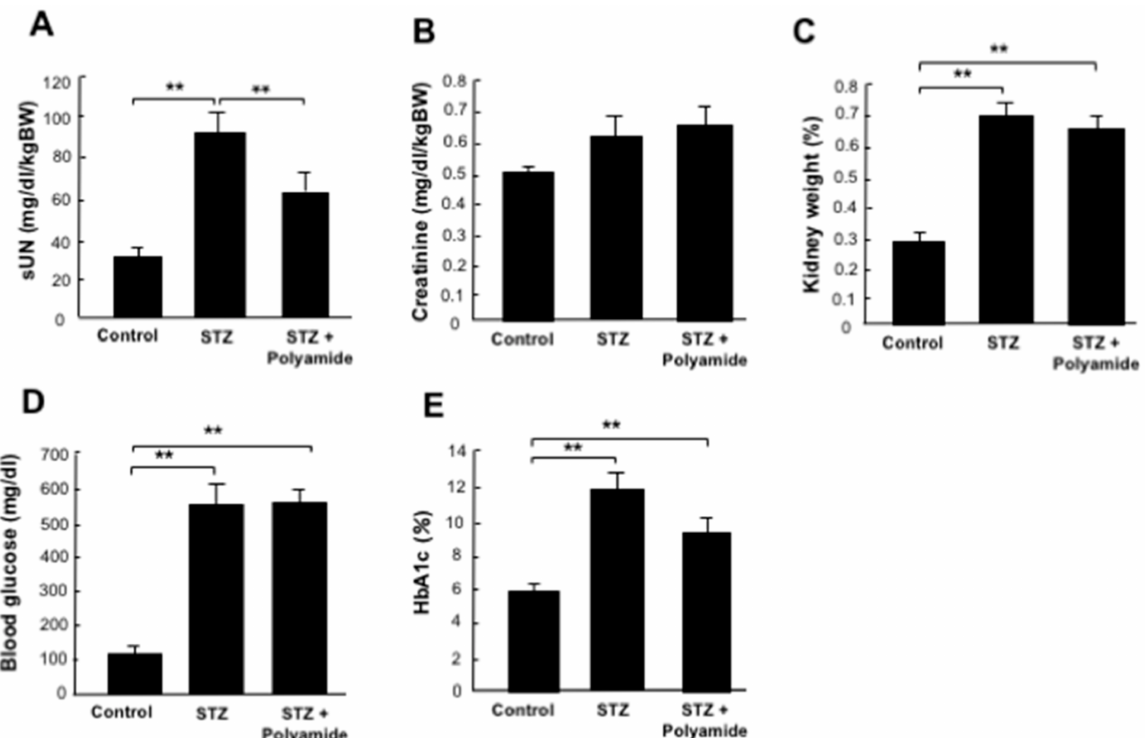
Figure 7. Effects of upstream stimulatory factor 1 (USF1) pyrrole-imidazole (PI) polyamide on ( A ) serum urea nitrogen (sUN), ( B ) serum creatinine, ( C ) kidney weight, ( D ) blood sugar and ( E ) serum HbA1c in diabetic rats. Diabetes mellitus was induced in rats by single intraperitoneal injection of streptozotocin (STZ). STZ-induced diabetic rats were intraperitoneally injected with 1 mL of 0.1% acetic acid as control rats. Then, 1 mg/kg body weight of USF1 PI polyamide dissolved in 1 mL of 0.1% acetic acid was intraperitonially injected twice a week for 4 months. Data are the mean ± SEM ( n = 6). ** p < 0.01 between indicated